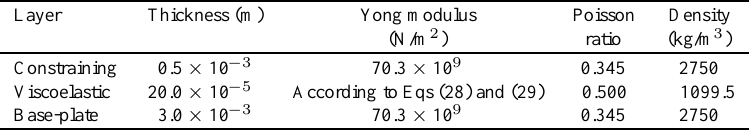
Table 1 Physical and geometrical properties of FE model of the three-layer plate